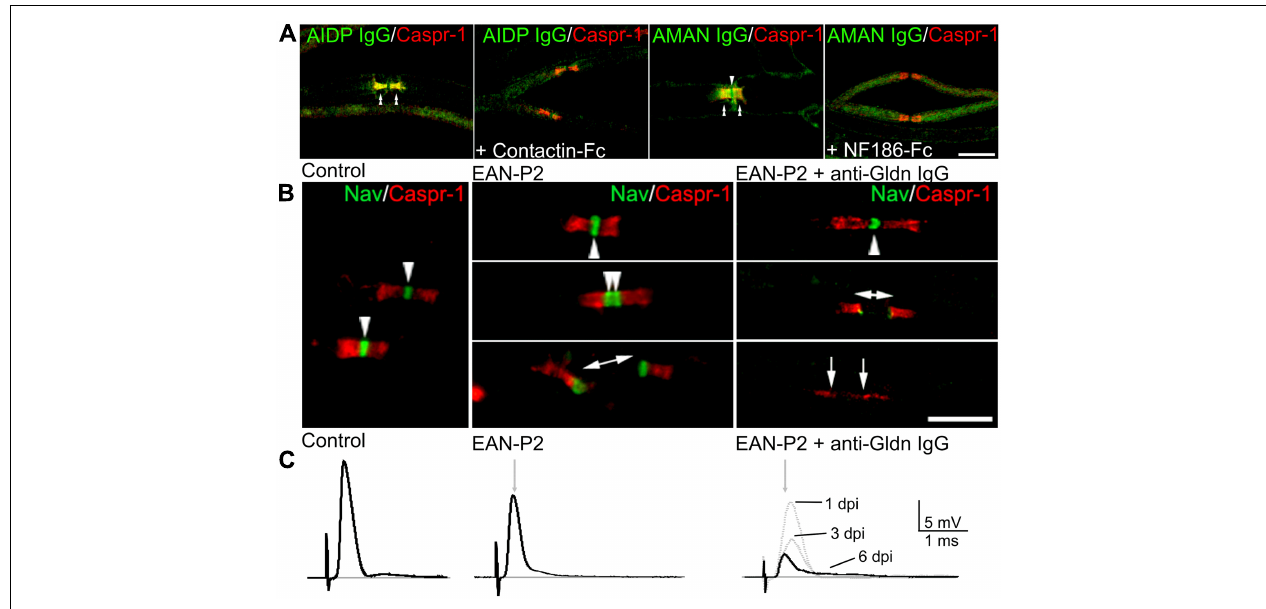
at hemi-nodes bordering the Schwann cells in demyelinated axons (bar with arrows). The injection of anti-Gliomedin IgG (here 6 days after IgG injection) induces the dispersion of Nav channels in demyelinated segments (between arrows). (C) Node disruption is associated with an important conduction slowing and loss in ventral roots of EAN-P2 animals injected with anti-Gliomedin IgG. The amplitude of the nerve potentials progressively decreased 1, 3, and 6 days post-injection (dpi) of anti-Gliomedin IgG. Gray arrows indicate the latency of control nerves. Scale bars: 10 μ m. Adapted from Lonigro and Devaux (2009); Devaux (2012), and Devaux etal.